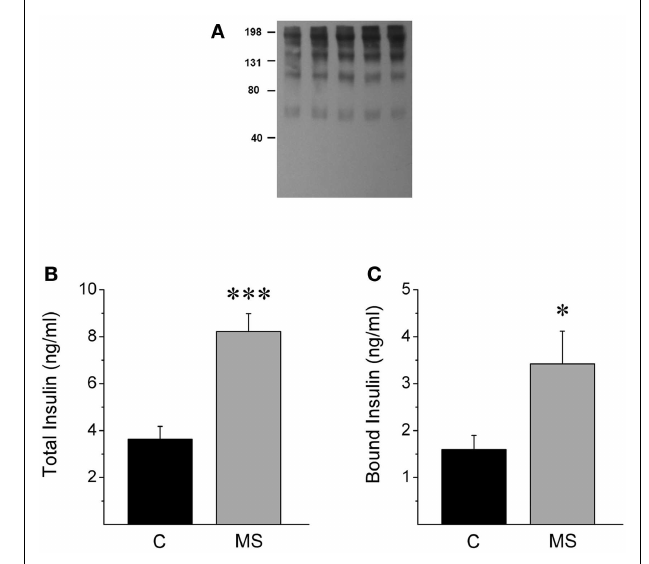
FIGURE 3 | MS rats show increased insulin binding to plasmatic proteins . (A) Western blot from plasma of control rats (lane 1, 2) and MS rats (3, 4, 5) that were previously separated using different Amicon centrifugal filters and immunoprecipitated with an insulin receptor (alpha-IR) in a native gel, stained with an anti-insulin antibody. Observe that insulin is present in different molecular weight bands, Section “Materials and Methods.” (B) Rats with metabolic syndrome (MS) show increased insulin levels when compared to control rats (C). (C) MS rats display higher insulin levels in the plasmatic fraction containing proteins above 30kDa, suggesting higher insulin binding to plasmatic proteins. Bars represent mean ± SEM of control ( n = 12) and MS rats ( n = 7), * p < 0.05 and *** p <